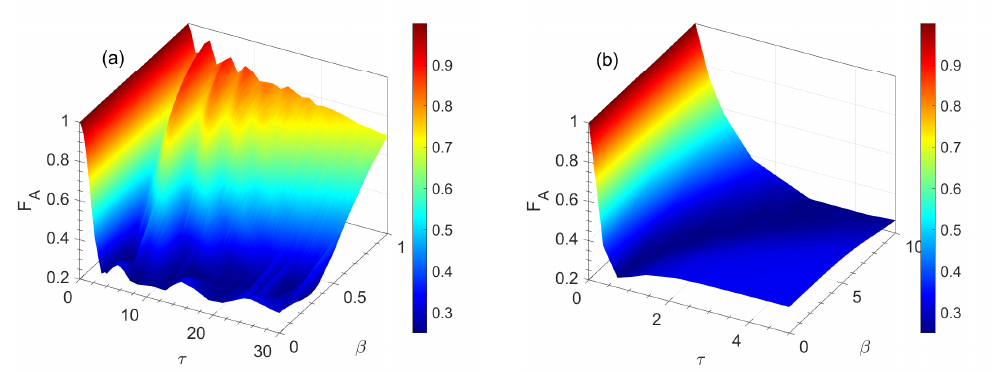
Figure 3. Average fidelity of teleportation in terms of the scaled time τ = γ 0 t and Stark shift parameter β for ( a ) non-Markovian λ = 0.1 γ 0 and ( b ) Markovian λ = 10 γ 0 regimes with µ = 1/